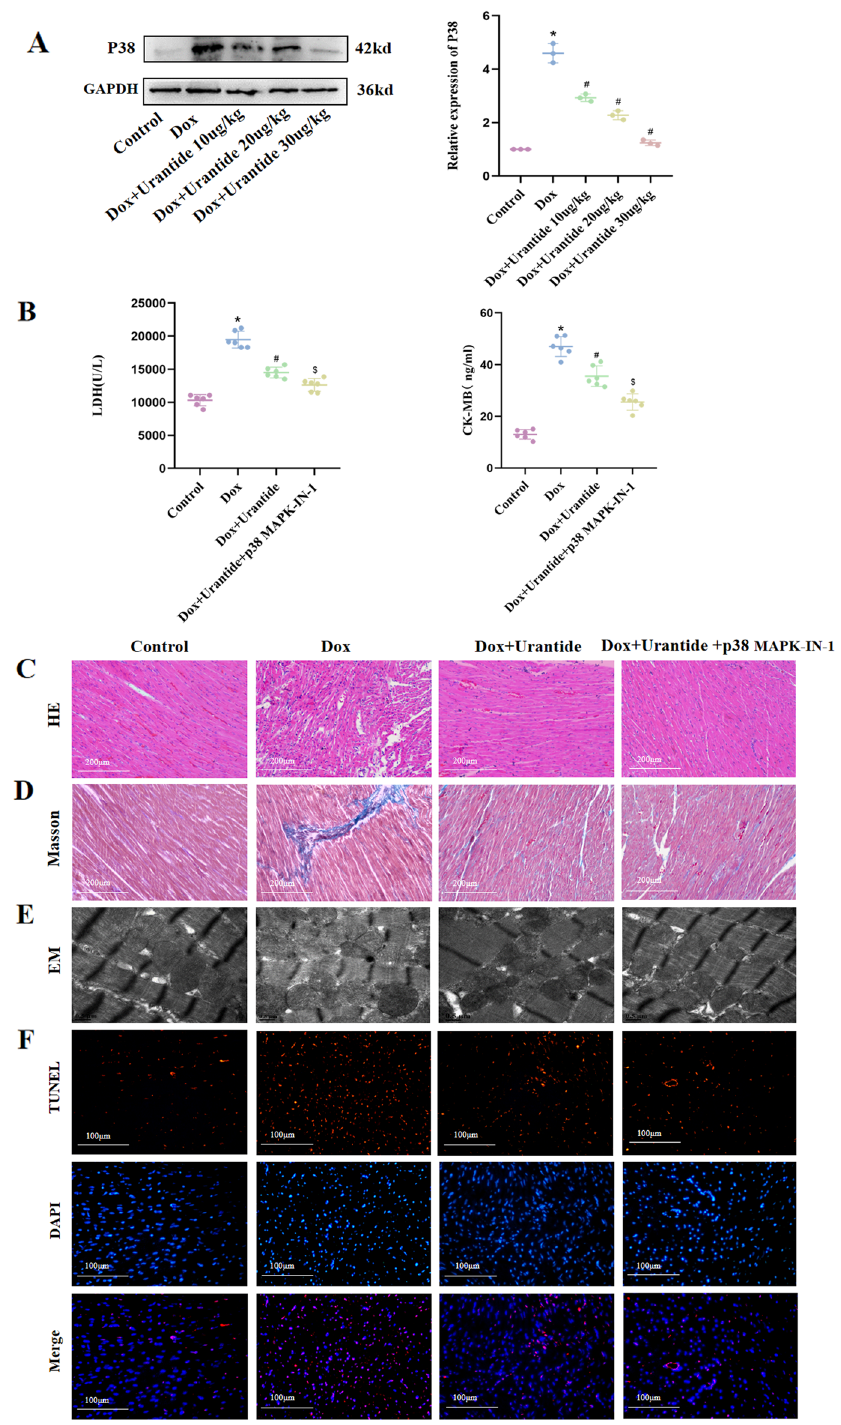
Figure 5. The attenuation of DOX-induced myocardial toxicity by Urantide was dependent on the downregulation of p38 in the MAPK pathway in vivo. ( A ) The expression level of the p38 MAPK pathway was downregulated in Urantide-treated. ( B ) CK-MB and LDH of the inhibitor group was decreased compared to Urantide ‐ treated rats. ( C ) Myocardial fiber appearance was more intense of the inhibitor group in HE staining. ( D ) Masson staining showed that the collagen content in the inhibitor group was significantly lower. ( E ) Transmission electron microscopy showing the beneficial of inhibitor. ( F ) Representative images of TUNEL staining of the heart tissues. ( G ) The levels of anti-apoptotic proteins were increased by the inhibitor. (n = 6). *P < 0.05, vs. the control; # P < 0.05 vs. the DOX group; $ P < 0.05 vs. the Urantide